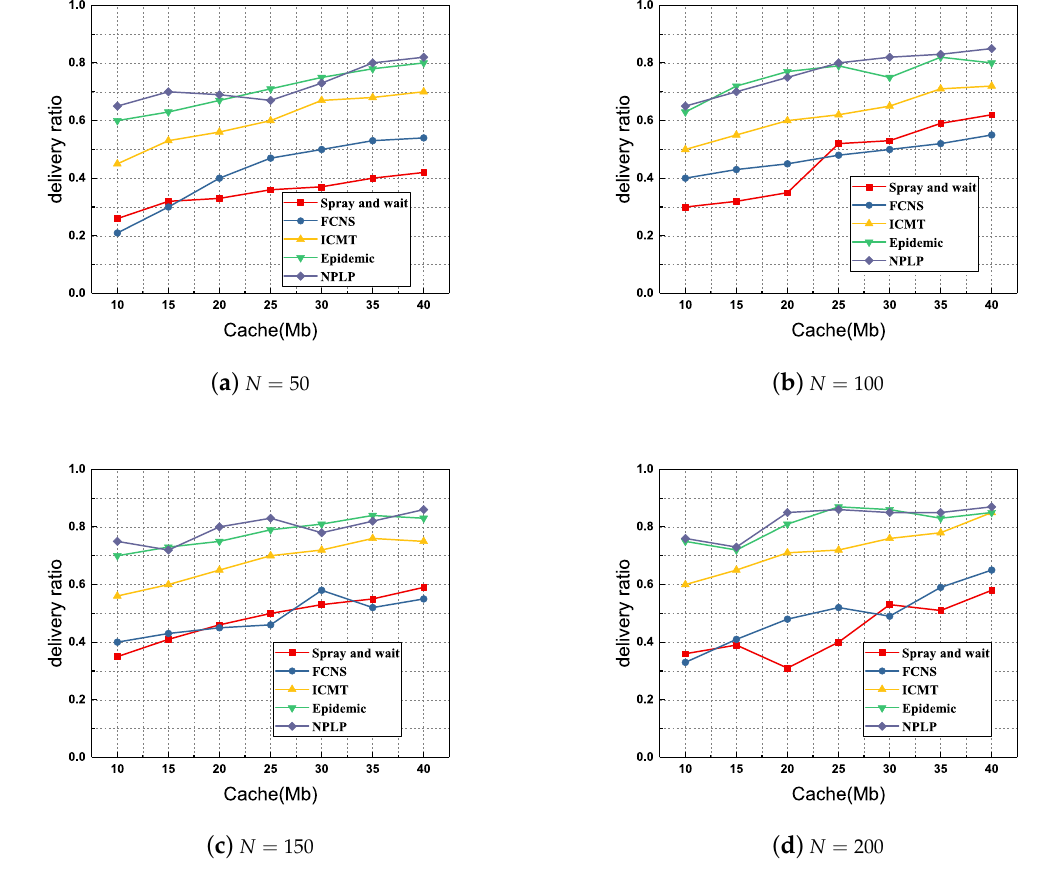
Figure 4. Performance comparison of delivery ratio between five algorithms with various cache spaces and various number of